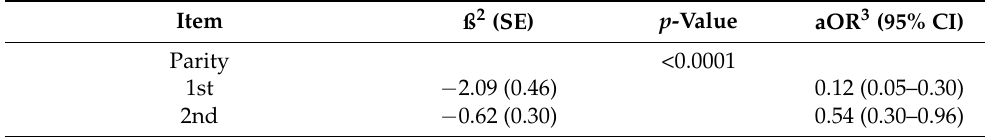
Table 3. Results of multivariable logistic regression model showing the association of parity, stage of lactation, average daily milk production, and milking speed with repeated forced take-off at the end of machine